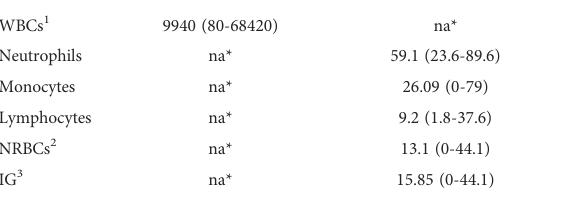
TABLE 2 BM cell populations evaluation. Assessment of the presence of bone marrow cell populations by an automated analyzer.